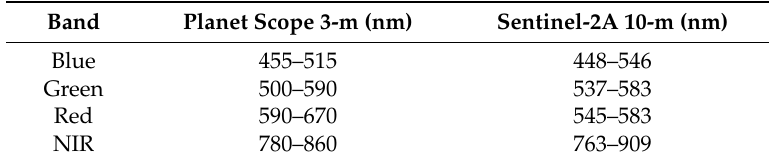
Table 1. Wavelength range of Planet and Sentinel-2A satellites sensors for blue, green, red, and NIR spectral